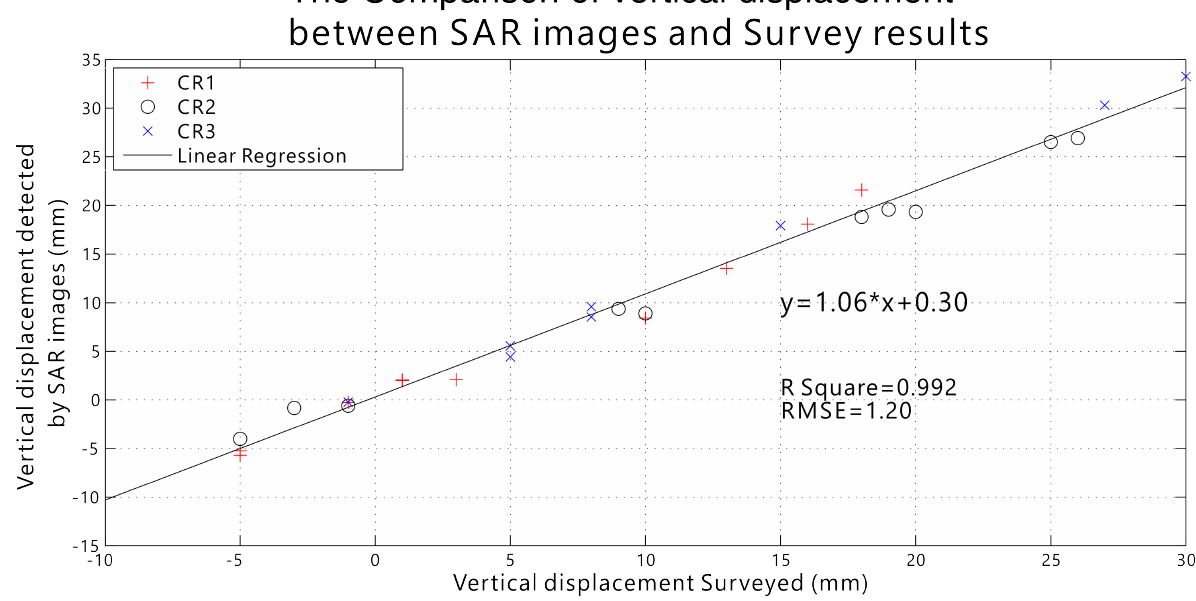
Figure 12. The statistical analyses of the deviation between the displacements computed from PSI and by the leveling survey